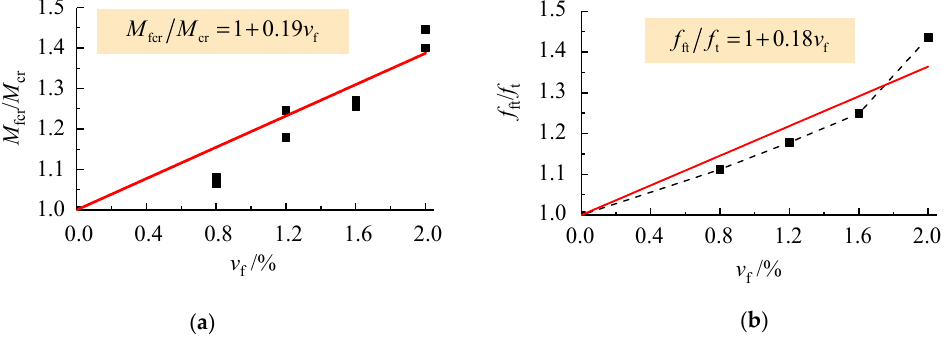
Figure 11. Comparison of the changes with v f : ( a ) M fcr ; ( b ) f ft .